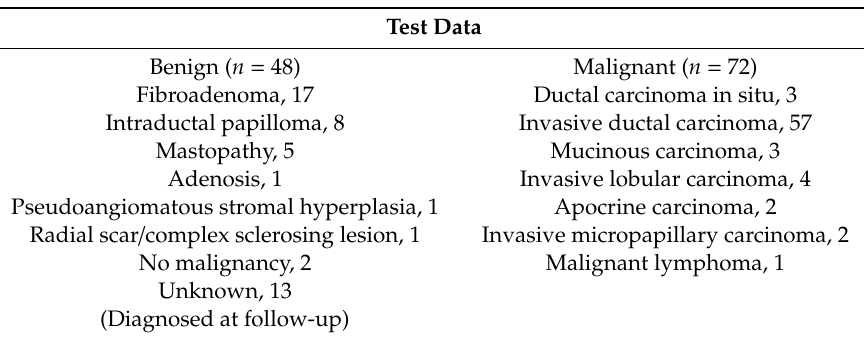
Table 2. Histopathology of